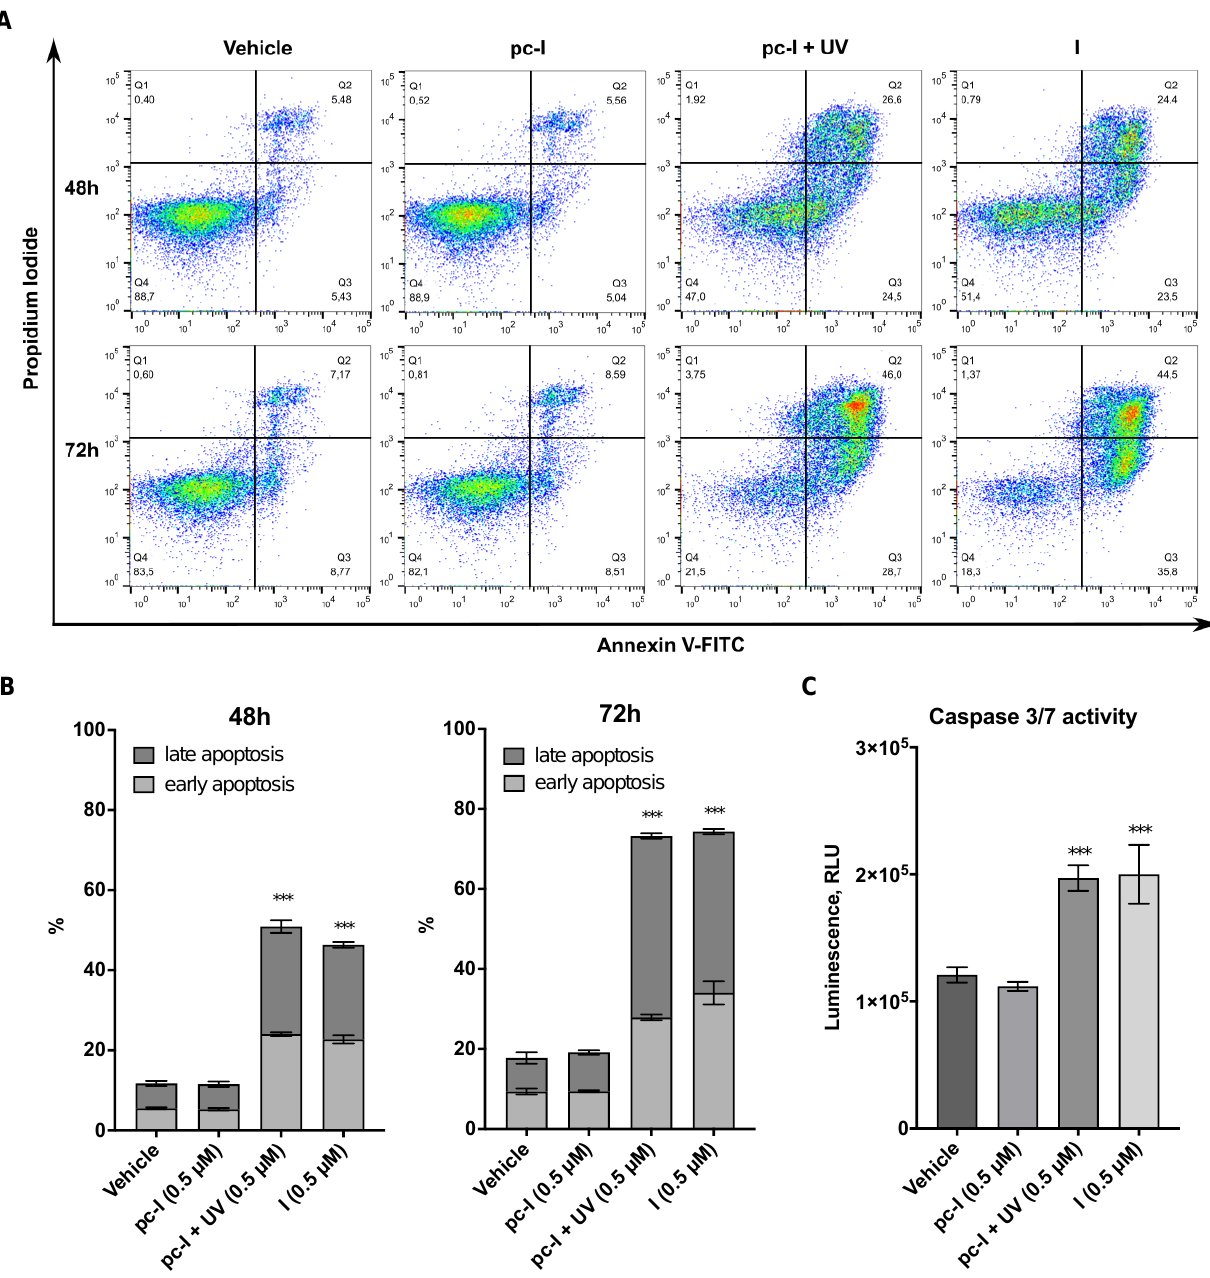
Figure 6. Results from apoptosis assays. A2780 cells were treated with 0.5 µM pc-I , pc-I + UV, I or vehicle (DMSO). ( A ) Cells were stained with annexin V and propidium iodide (PI) after 48 and 72 h. ( B ) Annexin-V-positive but PI-negative cells were classified as early apoptotic; annexin-V- and PI-positive cells were classified as late apoptotic. Statistical difference was calculated for annexin-V-positive cells compared to vehicle. ( C ) Cells were treated with the compounds and vehicle (DMSO) for 24 h, followed by incubation with caspase-Glo 3/7 substrate, and subsequently, luminescence was measured. For primary data, see Supporting Information Figure S2. Statistical analysis was performed with one-way ANOVA (*** p < 0.001).